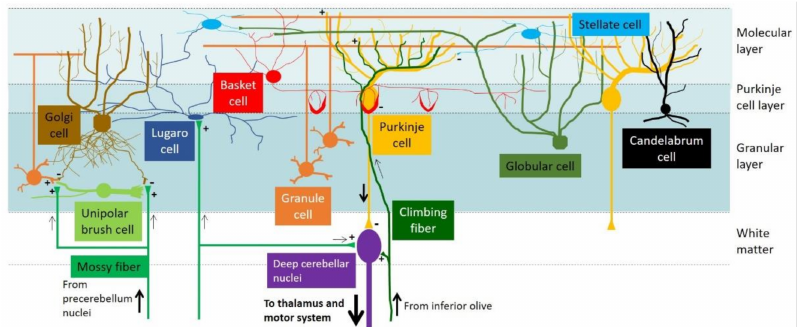
Figure 1. Cytoarchitecture and neuronal circuitry of the mouse cerebellar cortex. Dendrites of Purkinje cells (PCs) form synaptic connections with the parallel fibers of granule cells (GCs) within the molecular layer. PCs relay the signals from GCs and other interneurons and send the final output to the deep cerebellar nuclei. Mossy fibers and climbing fibers are the major afferents from outside the cerebellum. Interneurons are located in different layers of the cerebellar cortex: stellate cells and basket cells in the molecular layer; PCs and candelabrum cells in the Purkinje cell layer; and GCs, unipolar brush cells, globular cells, and Lugaro cells in the granular layer. For further details and additional references, please refer to